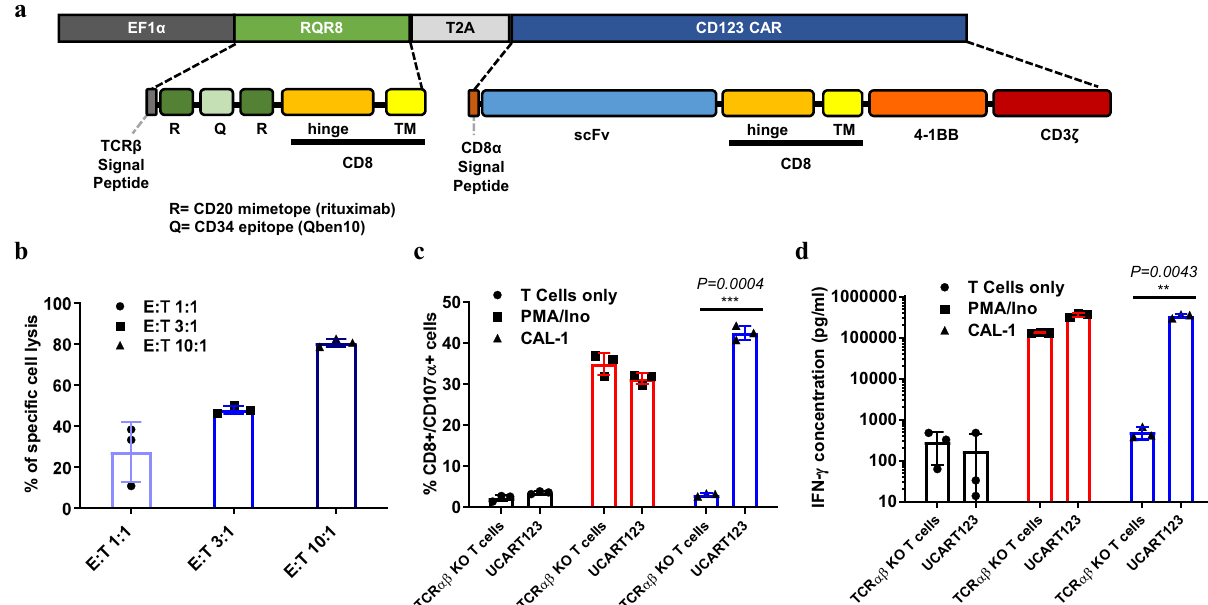
Fig. 1 Cytotoxicity of UCART123 against CAL-1 BPDCN cells in vitro. a UCART123 cells express (i) a second-generation chimeric antigen receptor (CAR; CD123 scFv-4-1BB-CD3z) directed against CD123 and (ii) the “ safety switch ” RQR8 depletion ligand. b CAL-1 BPDCN cells were co-cultured with either non-transduced TCR αβ -de fi cient (TCR αβ KO) T cells or with UCART123 cells at various effector: target (E:T) ratios indicated for 16 h. The speci fi c cytotoxic activity of UCART123 against CAL-1 target cells was calculated. Each point represents the data obtained from triplicate experiments, and the mean ± SD value is presented. c CD107 α degranulation was measured by fl ow cytometry gating on CD8 + cells after co-culture with UCART123 or TCR αβ KO T cells at E:T = 1:1 for 6 h. “ T cells only ” correspond to the basal activity of unstimulated T cells, while PMA/Ion corresponds to the signal observed upon nonspeci fi c stimulation by phorbol myristate acetate and ionomycin. Data represent n = 3 biological replicates and mean ± SD of triplicates. Signi fi cance was determined using unpaired two-tailed t-test annotated as ***P ≤ 0.001. d CAL-1 cells were co-cultured with either TCR αβ KO T cells or with